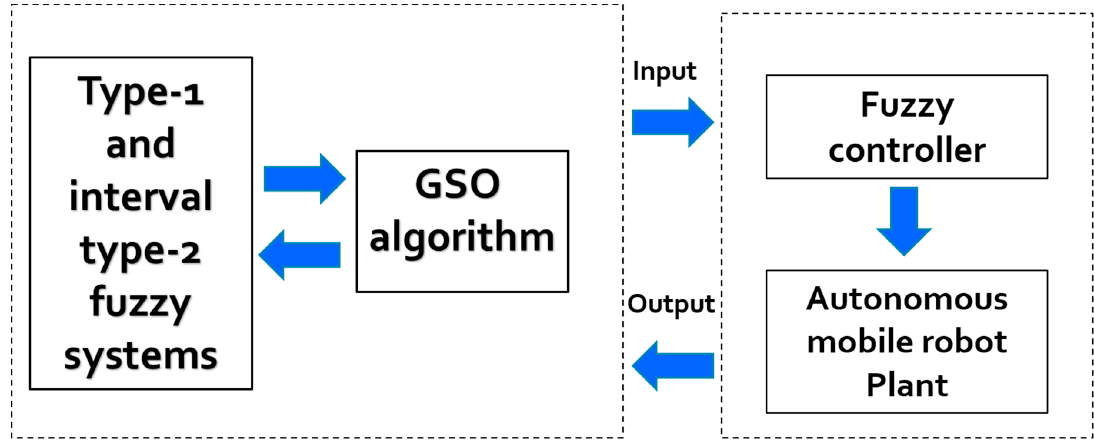
Figure 1. Proposed method.